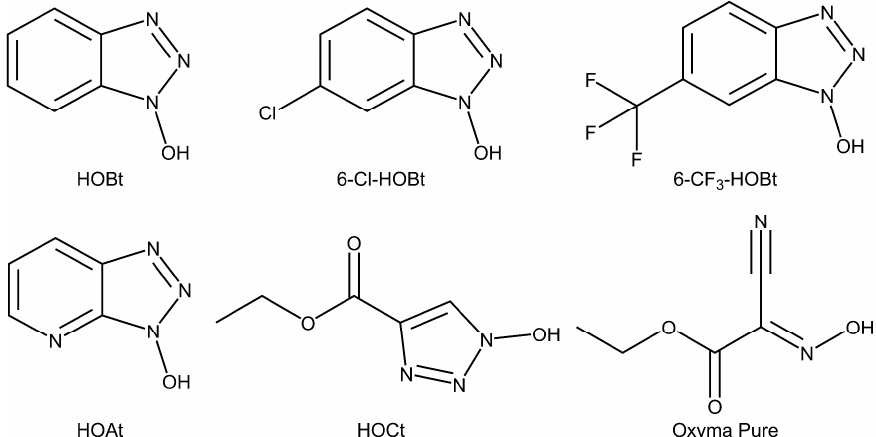
Figure 1. Chemical structure of the catalysts evaluated in this study. HOBt: 1-hydroxybenzotriazole, 6-Cl-HOBt: 6-chloro-1-hydroxybenzotriazole, 6-CF 3 -HOBt: 1-hydroxy-6- (trifluoromethyl)benzotriazole, HOAt: 3-hydroxytriazolo[4,5-b]pyridine, HOCt: ethyl 1- hydroxytriazole-4-carboxylate, Oxyma Pure: ethyl (2E)-2-cyano-2-hydroxyiminoacetate.